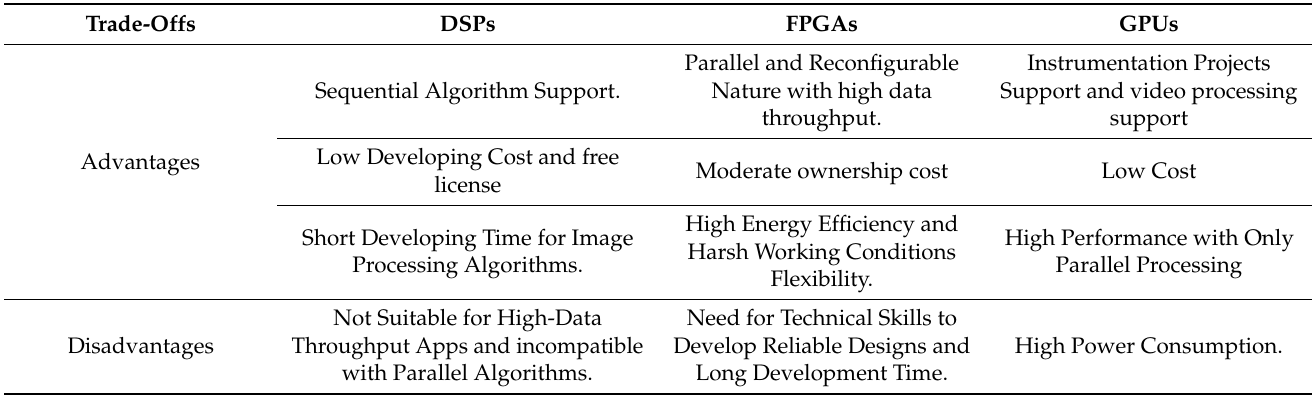
Table 2. DSPs vs. FPGAs vs. GPUs